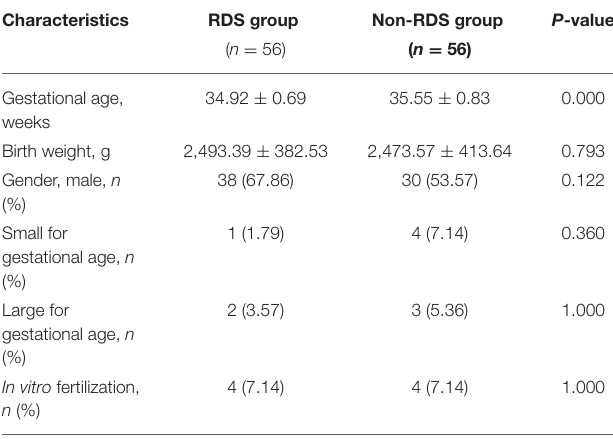
TABLE 1 | Baseline characteristics of 112 preterm infants.